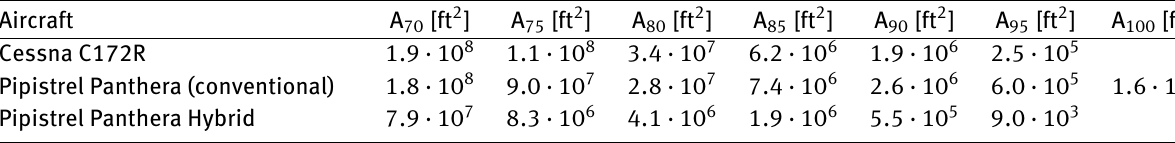
Table 11: SEL contoured areas for the three aircraft under analysis in section 3.2. Data corresponding to the plots in Figure 7.